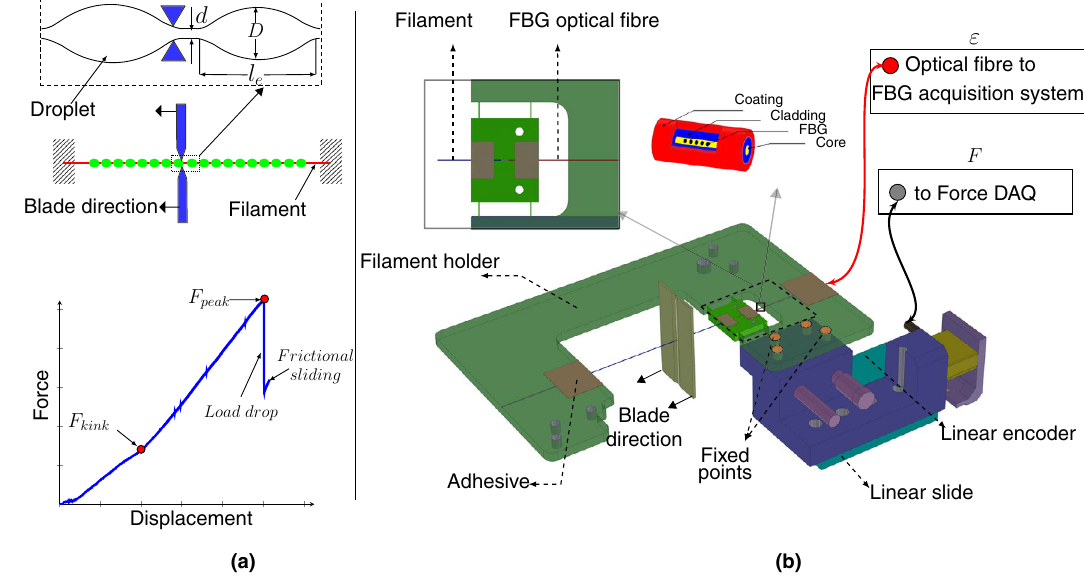
Figure 1. ( a ) The traditional MB test and related parameters. ( b ) The experimental setup of a MB test system with the CBPM-FBG filament holder concept. [( a ) is generated using latex-pgf plot package, ( b ) is generated using Solidworks software, version 2018, https:// www. solid works.